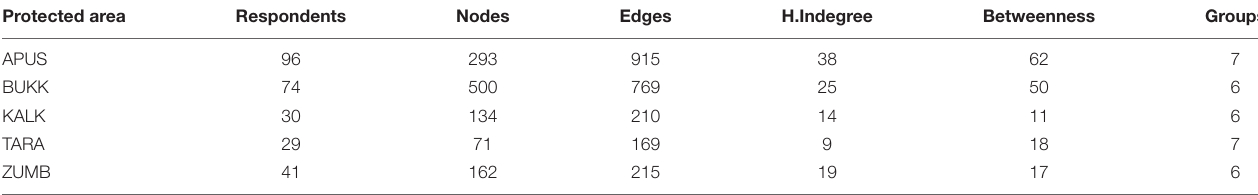
TABLE 1 | Basic description of the network graphs. Protected area Respondents Nodes Edges H.Indegree Betweenness Groups